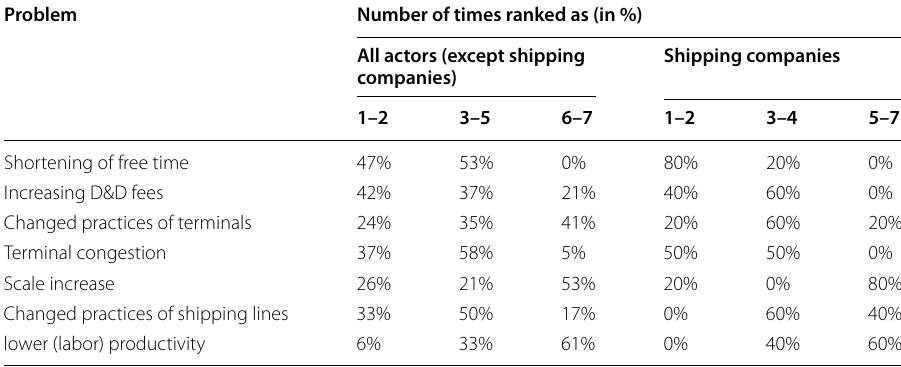
Table 1 Elements linked to D&D. Source : own compilation Problem Number of times ranked as (in